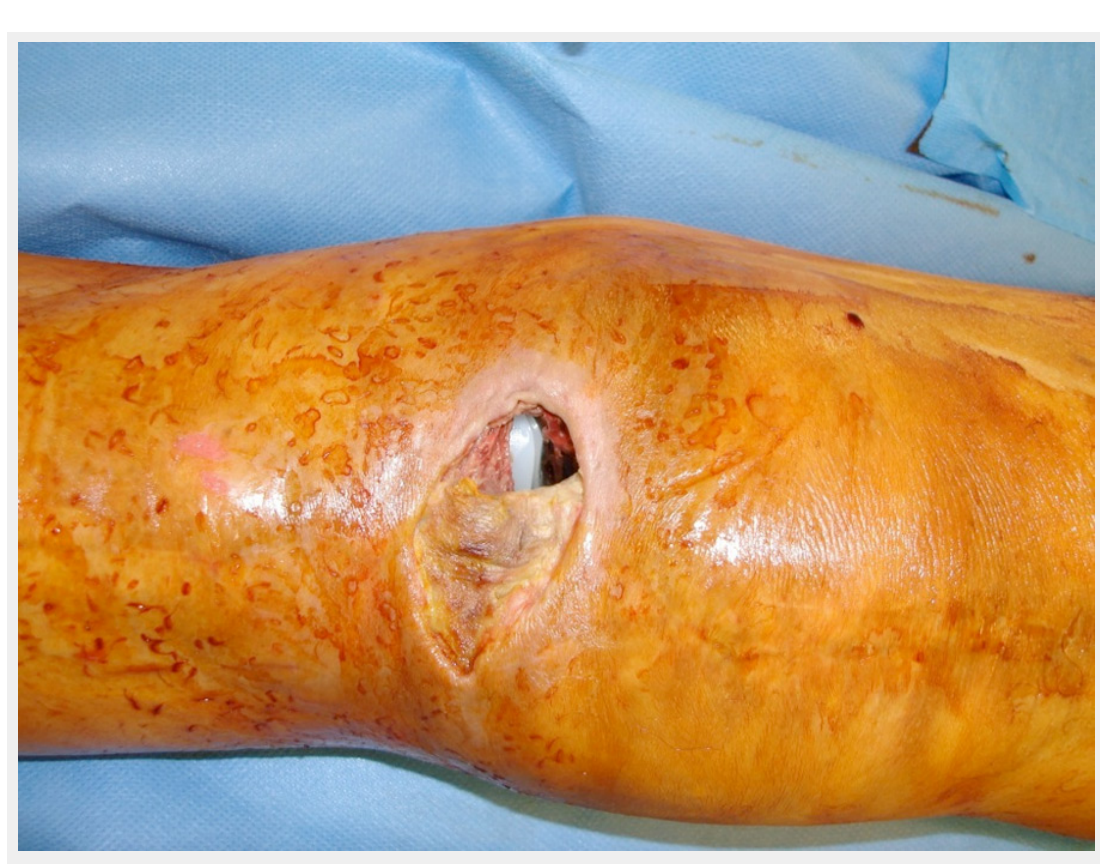
Figure 6 A worst-case scenario of a chronic periprosthetic infection with severe soft tissue